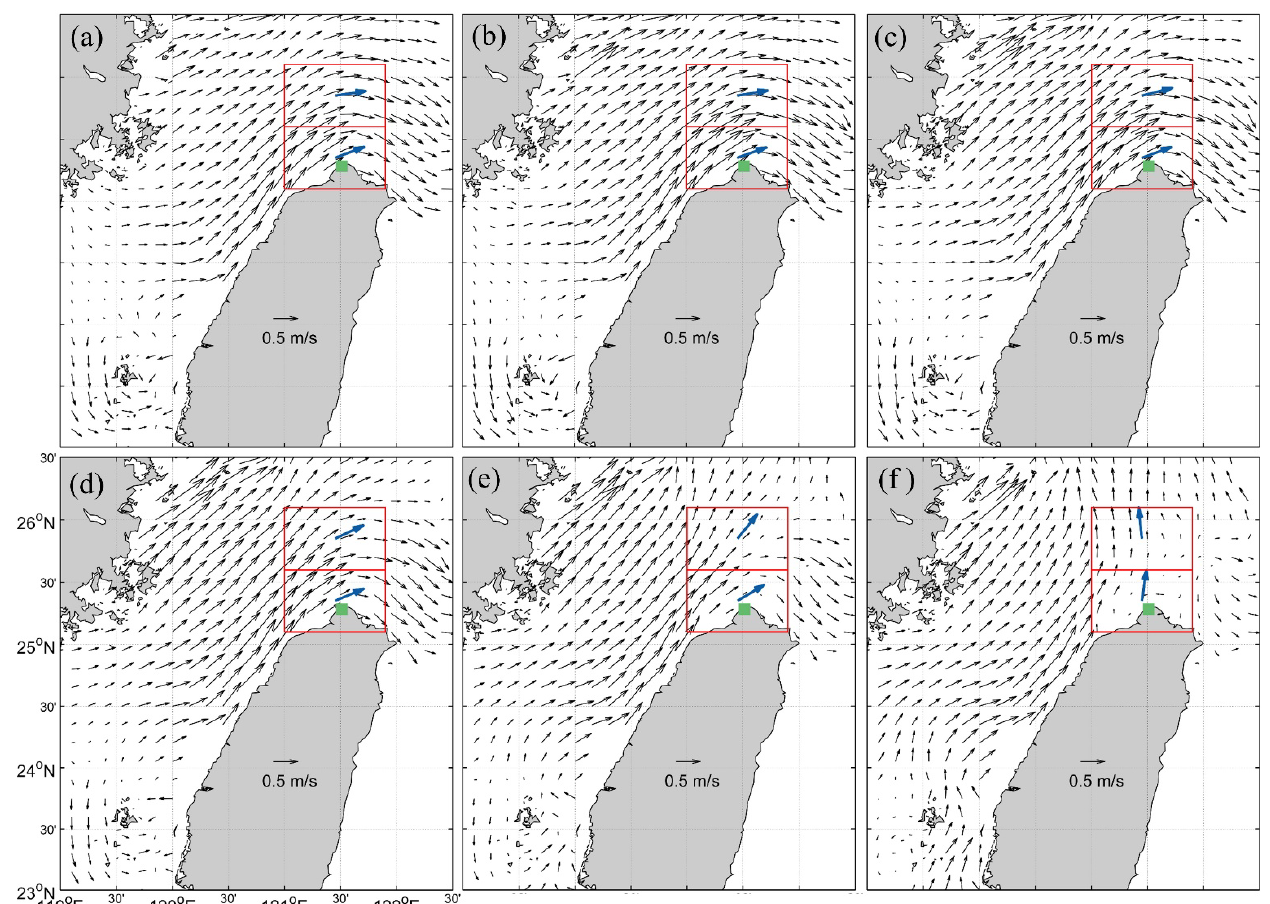
Figure 3. Average flow fields of six-hour periods ( a ) after high tide, ( b ) from one hour after high tide, ( c ) from two hours after high tide, ( d ) from three hours after high tide, ( e ) from four hours after high tide, and ( f ) from five hours after high tide in the summer of 2017. The green square is the tidal station (Linshanbi, located at 25.2839° N, 121.5103° E). The blue arrows represent the averages of flow directions north of Taiwan.